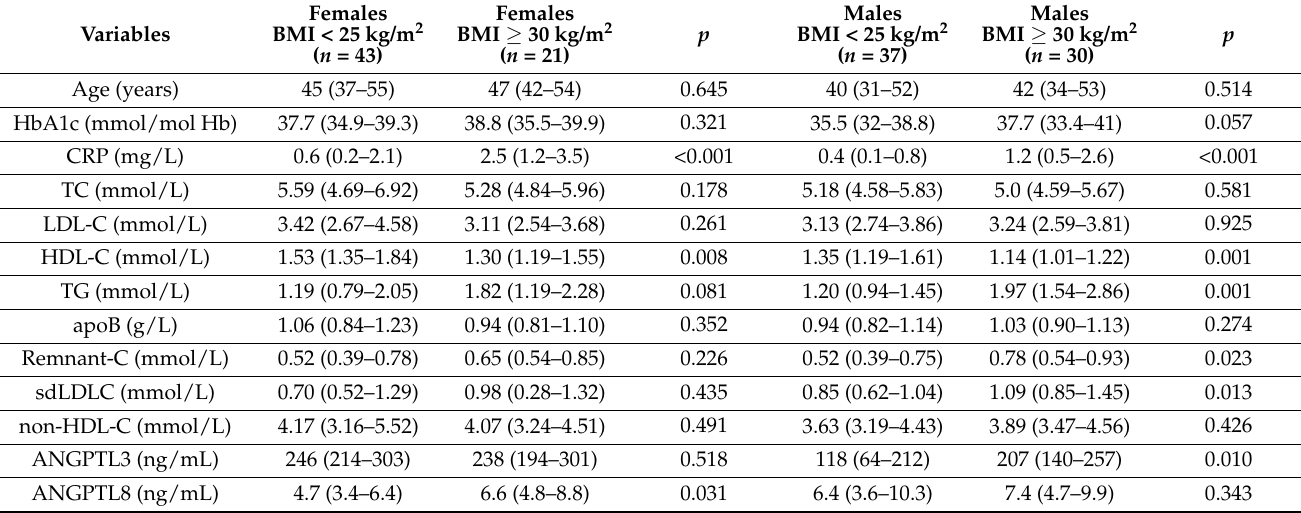
Table 3. Concentrations of assessed biochemical markers in normal weight (BMI < 25 kg/m 2 ) and obese (BMI ≥ 30 kg/m 2 ) subjects, stratified by